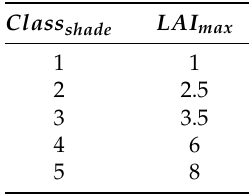
Table A24. NECN maximum LAI parameters.